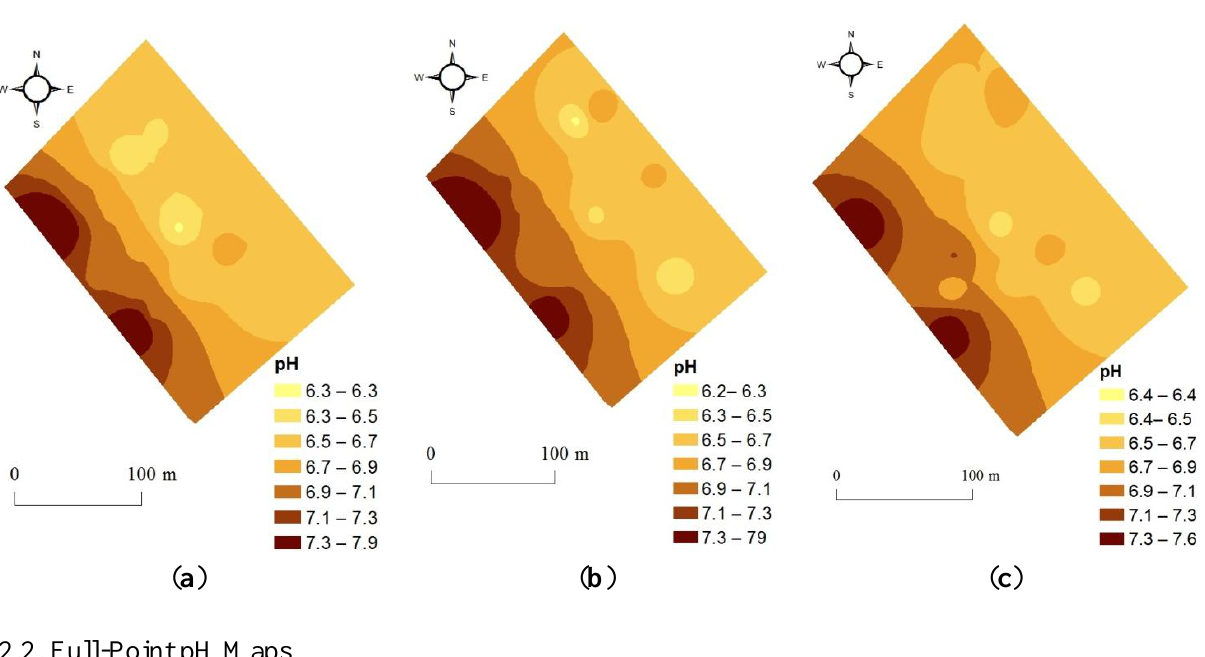
Figure 4. Comparison maps between ( a ) laboratory measured, ( b ) off-line visible end near infrared (vis-NIR) predicted, and ( c ) on-line vis-NIR predicted pH, based on 16 samples of the validation